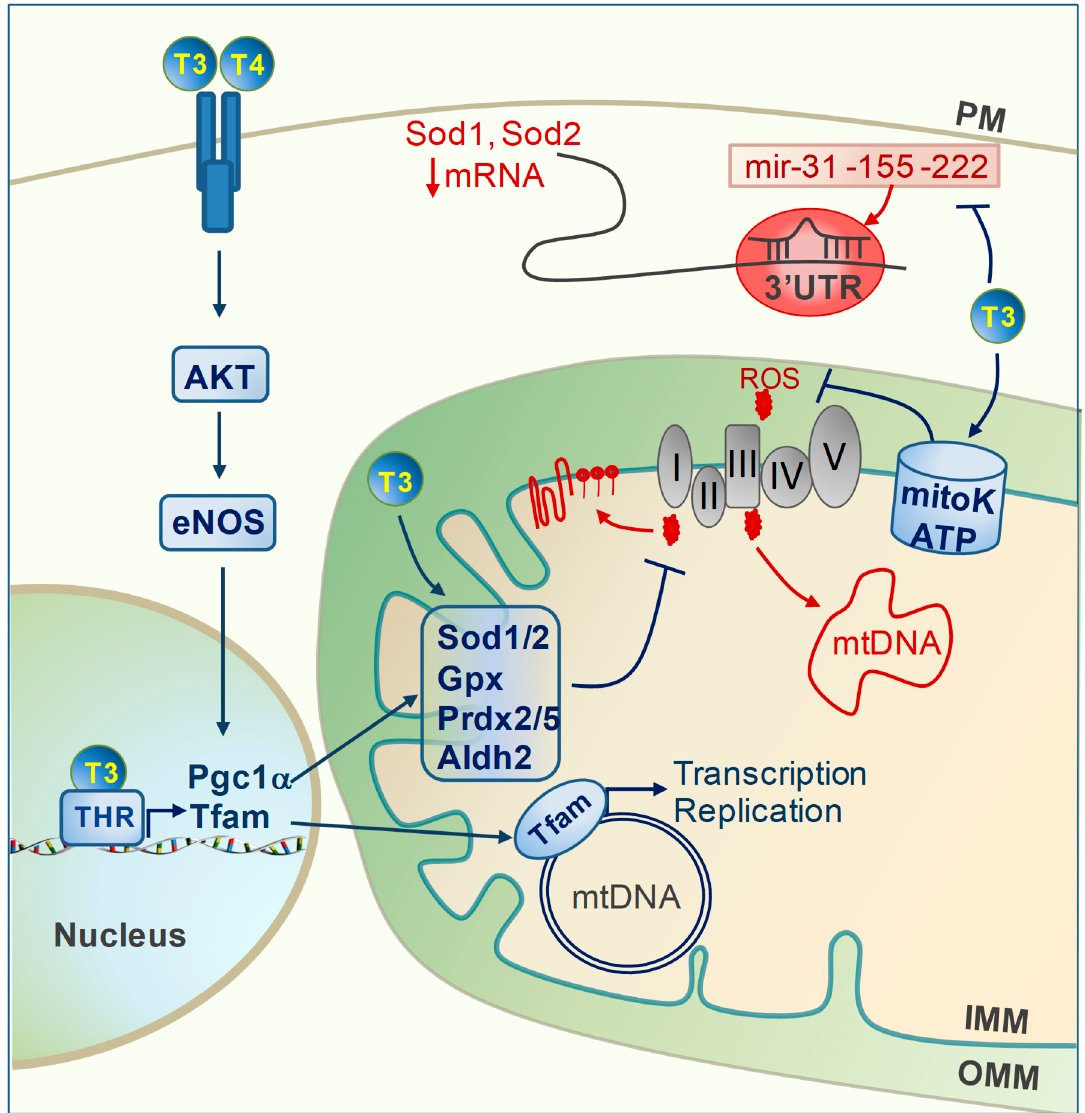
Figure 1. Antioxidant effect of thyroid hormones (TH). Reactive oxygen species (ROS) produced at electron transport chain (ETC) complex I and III can damage mitochondrial DNA, lipids, and proteins. T3 and T4 decrease reactive oxygen species (ROS) production by multiple mechanisms: (1) membrane-initiated pathways as for the AKT/eNOS axis; (2) transcriptional regulation of Pgc1 α and Tfam; (3) post-transcriptional regulation via inhibition of mir-31, -155, and -222; (4) activation of the mitoK-ATP protective channel. Effectors modulated by TH are marked in blue. (AKT: protein kinase B; Aldh2:aldehyde dehydrogenase 2; eNOS: nitric oxide synthase; IMM: inner mitochondrial membrane; Gpx; Glutathione peroxidase mtDNA: mitochondrial DNA; OMM: outer mitochondrial membrane; Pgc1 α : PPARG coactivator 1 alpha; PM: plasma membrane; Prdx2/5: peroxiredoxin 2/5; Sod1/2: superoxide dismutase1/2; Tfam: mitochondrial transcription factor A; THR: thyroid hormone receptor).